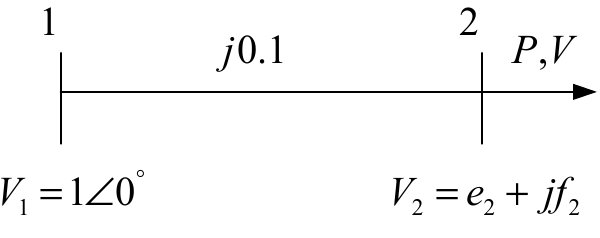
Figure A1. Two-bus power system.